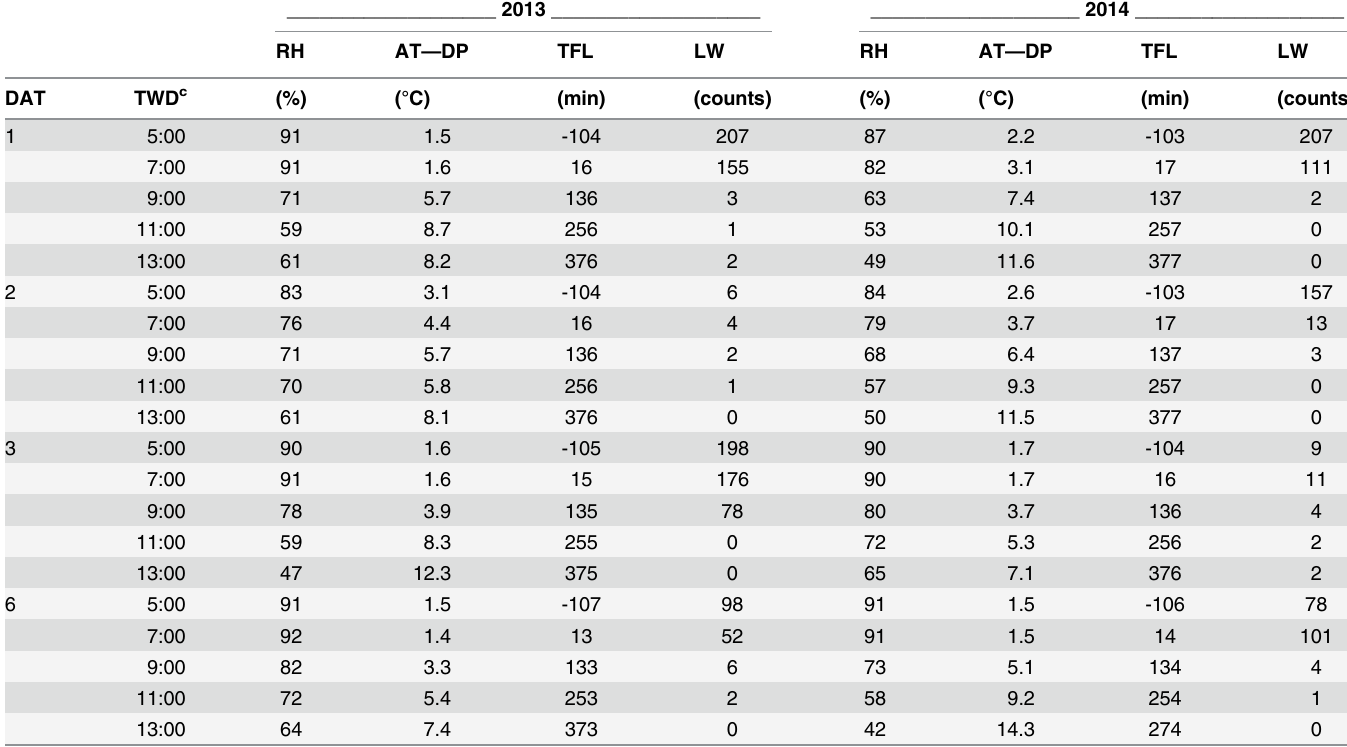
a Abbreviations: DAT, d after treatment; TWD, time within a day; RH, relative humidity; AT, air temperature; DP, dew point; TFS, time from sunrise; LW, leaf wetness. b Climatic conditions recorded on site at the Lake Wheeler Turfgrass Field Lab (Raleigh, NC, USA). c Eastern standard